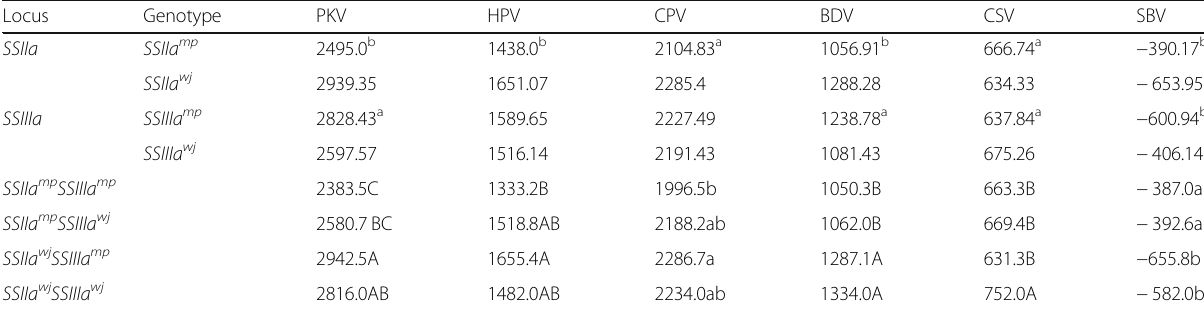
Table 7 Difference of RVA profiles for different genotypes in SSIIa and SSIIIa locus of 64 semi waxy lines Locus Genotype